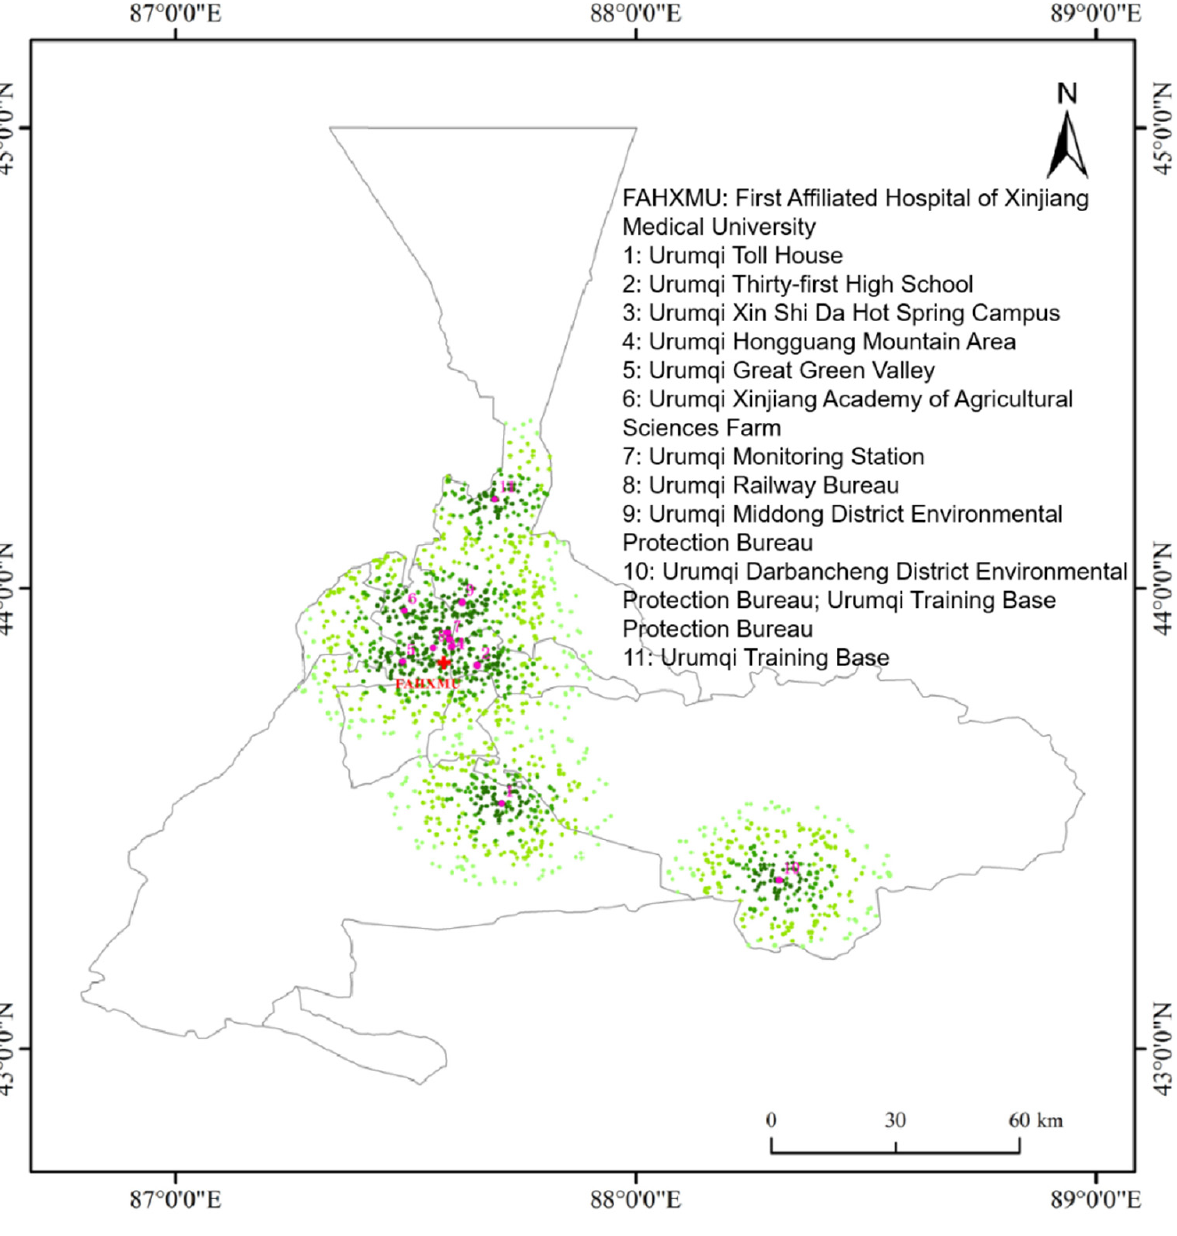
Figure 1. Location of environmental monitoring stations and hospital in Urumqi, Xinjiang. The location of each air quality monitor is marked with a pink dot; the location of the hospital is marked with a red cross; the home address of each recruited patient is marked with a green dot.